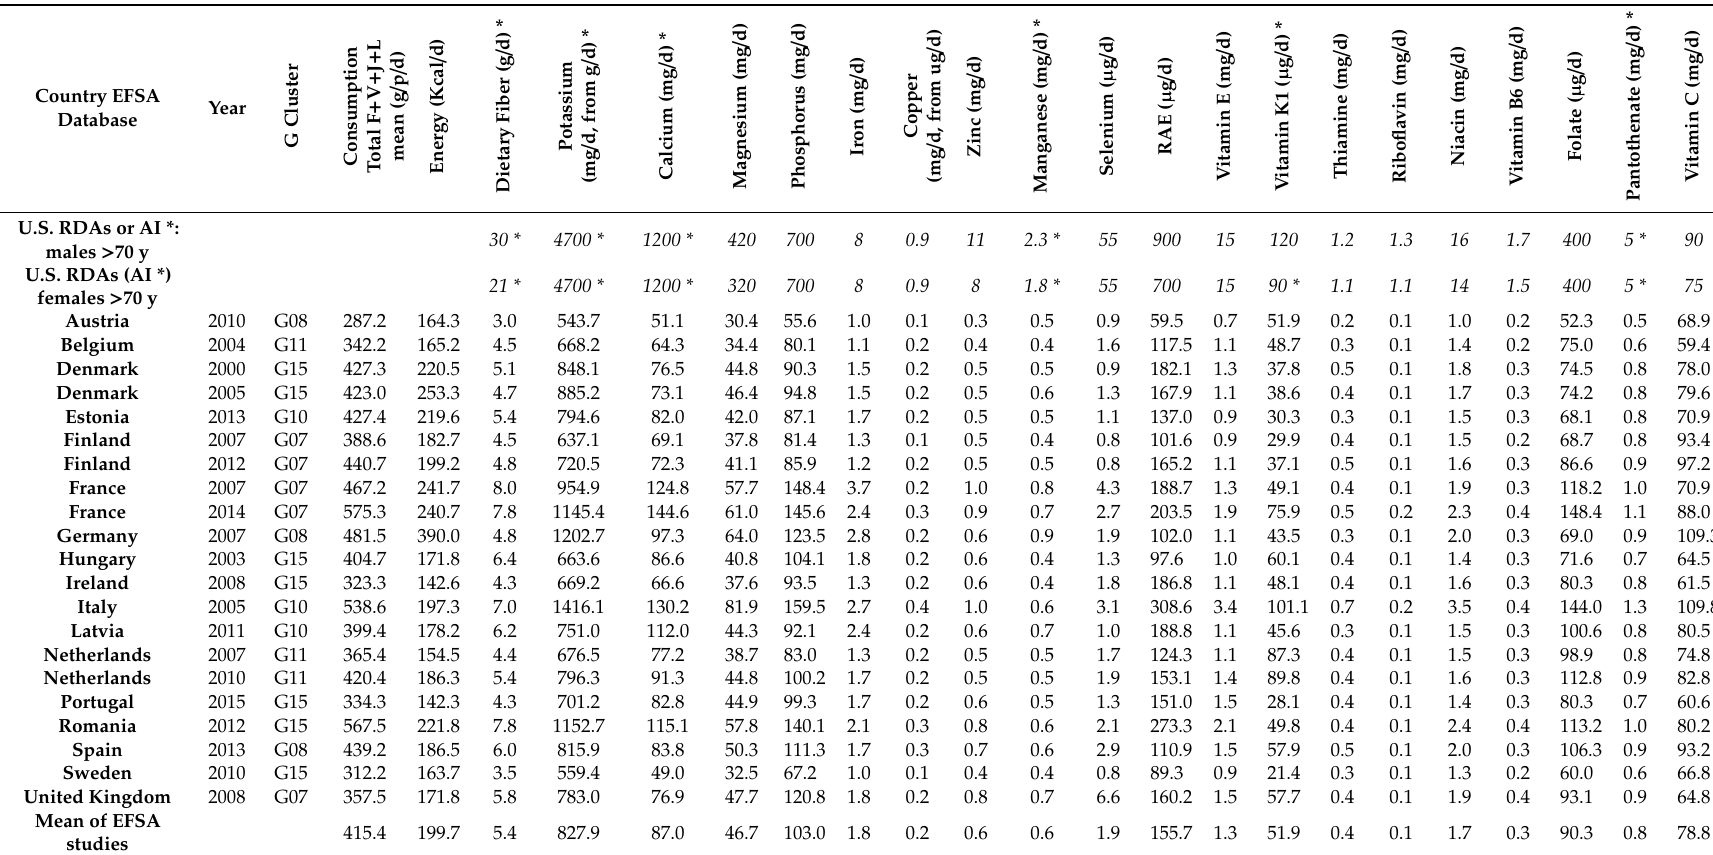
Table 4. EFSA database estimating daily availability of fiber and nutrients from total fruits, vegetables, and legumes. Estimated daily elderly intake of fiber and nutrients from total fruits, vegetables, fruit and vegetable juices, and legumes (determined and summed from the mean consumption of each individual product at level 7 in the EFSA database (65–74 years) and corresponding nutrient data in food conversion databases). The US recommended dietary allowances (RDAs) or adequate intakes (AIs *) are shown for males and females aged > 70